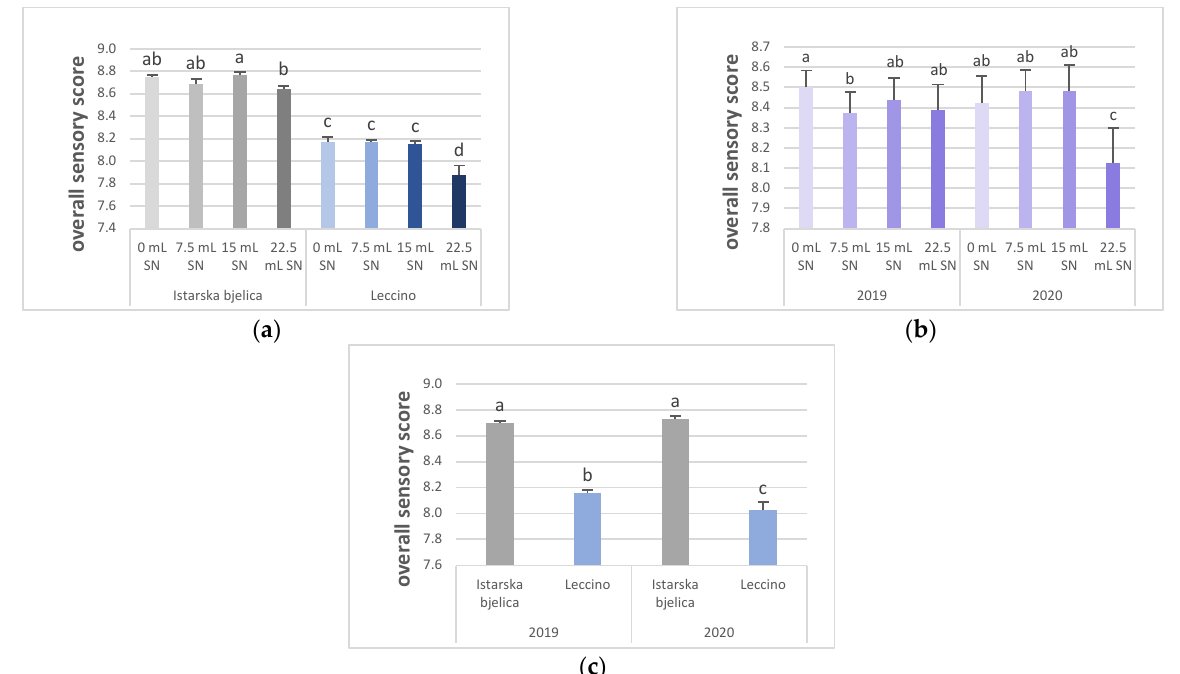
Figure 5. Multiple comparisons of the effects of ( a ) treatment (T) (0, 7.5, 15, and 22.5 mL of applied SN foliar fertilizer per 1 L of water) and cultivar (Cv.) (Istarska bjelica, Leccino), ( b ) treatment and year (Y) (2019, 2020), and ( c ) cultivar and year on the overall sensory score of olive oil. Different superscript lowercase letters represent statistically significant differences between the mean values at p < 0.05 that were obtained by a three-way ANOVA and Tukey’s test. was also observed for the Istarska bjelica cultivar VOOs of 0 mL SN treatment (Figure S7h).